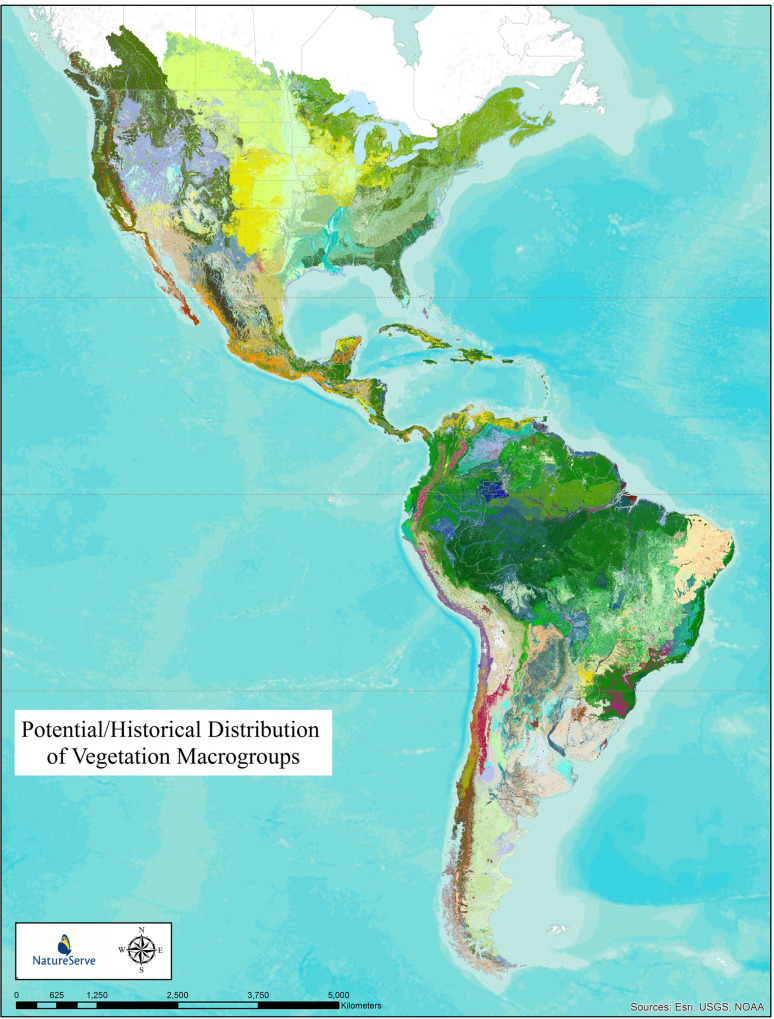
Potential/historical distribution of vegetation macrogroups.Potential distribution of 315 vegetation macrogroups across Temperate and Tropical North and South America. Individual types are too numerous to list in a legend, but this provides a depiction of patterns that will be discernable in part in subsequent figures.